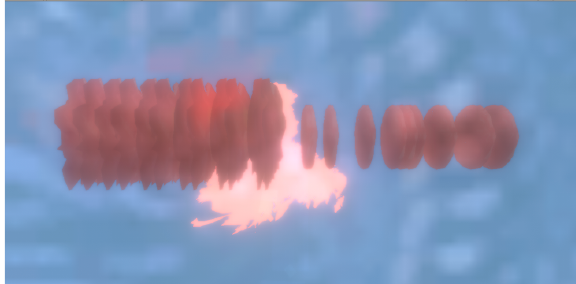
Figure 1: Stereo virtualizer demo, objects in the row on the left are controlled by analysis of the left audio channel, those on the right from the right channel, the central background shape from analysis of the mix The Unity plug-in code is available at <https://github.com/sicklincoln/MusicalMachineListeningUnit yPlugin> under a permissive BSD-3-Clause license.